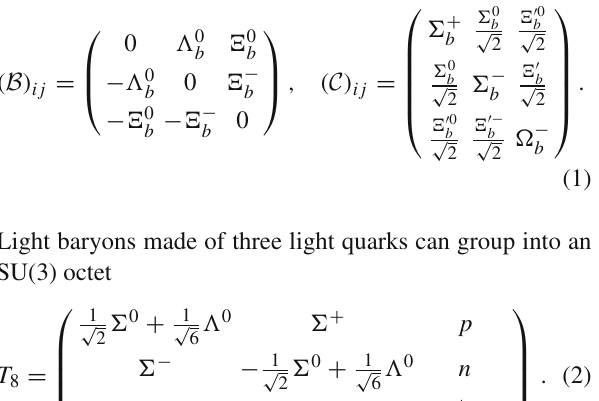
→ K − P c (left) and the analogous b